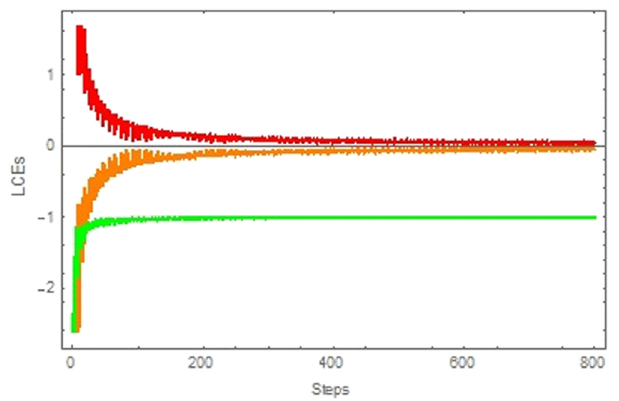
Figure 4: The convergence plot of the LEs for Hide ’ s model with initial conditions and parameter values = { } x 0.2, 0.1, 0.59 0 , = β 1.01 , = α 100 , = λ 1 , = κ 1